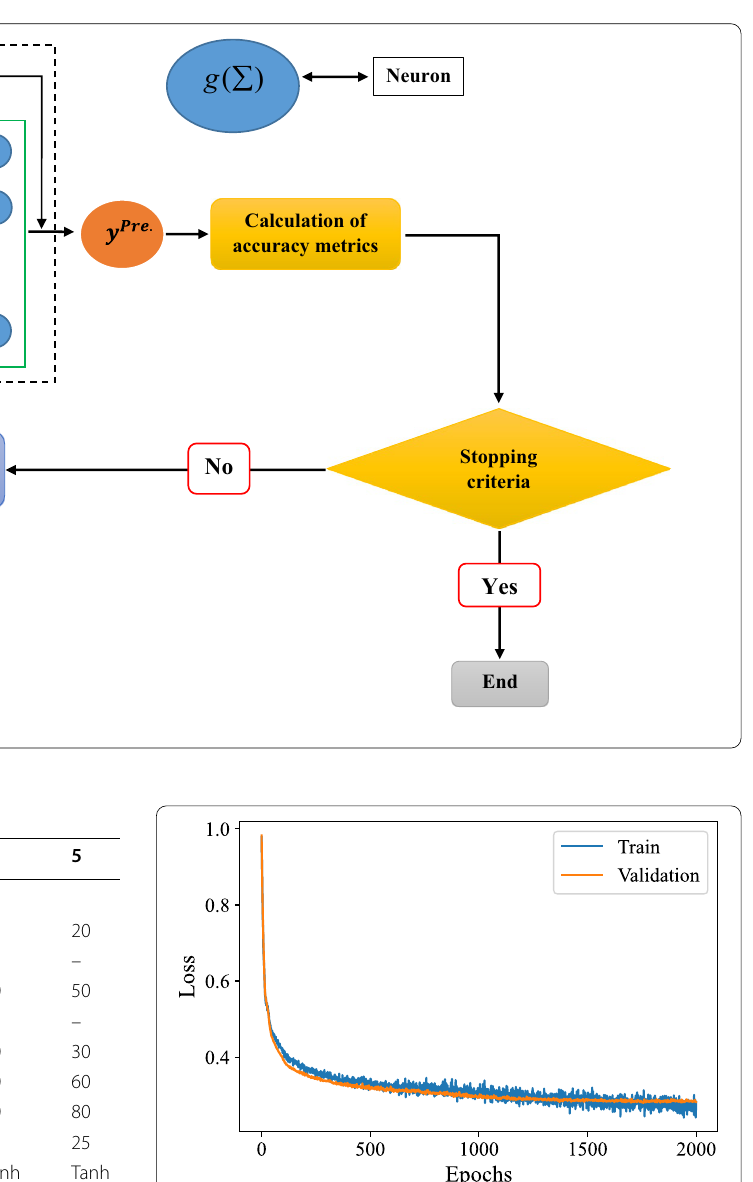
Fig. 4 Learning curve of sub-model